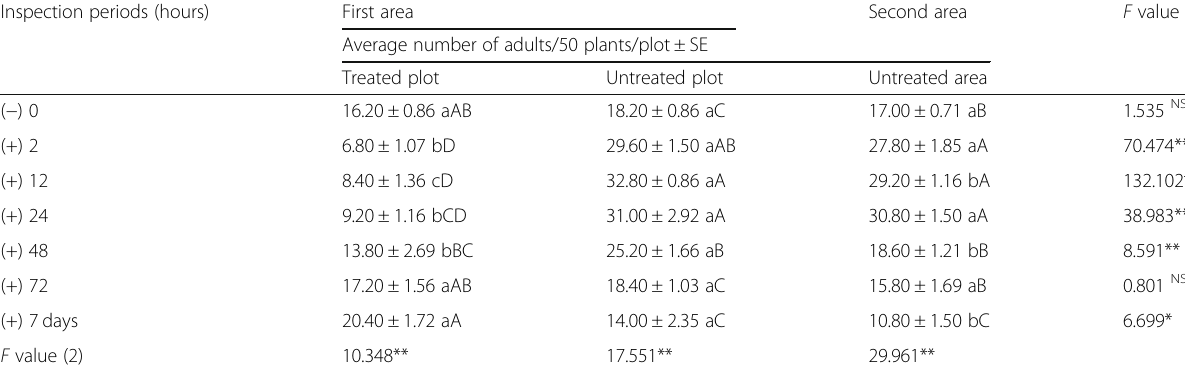
Table 1 Population densities of Coccinella undecimpunctata adults in untreated and sulfur-treated marrow cultivations Inspection periods (hours)